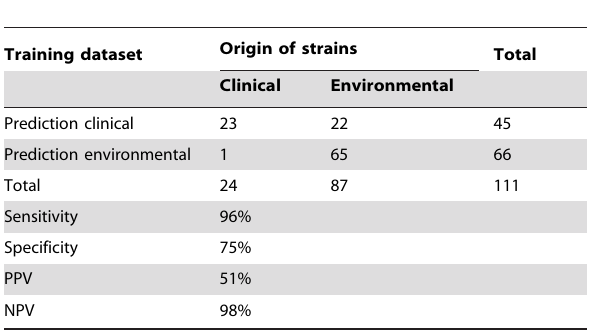
Table 1. Prediction results for the 111 strains in the eleventh training dataset.